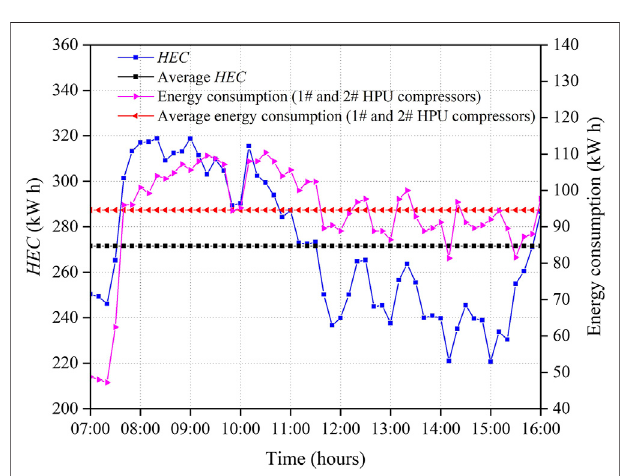
FIGURE 9 | HEC of system and energy consumption as a function of time during heating period (January 17, 2018).